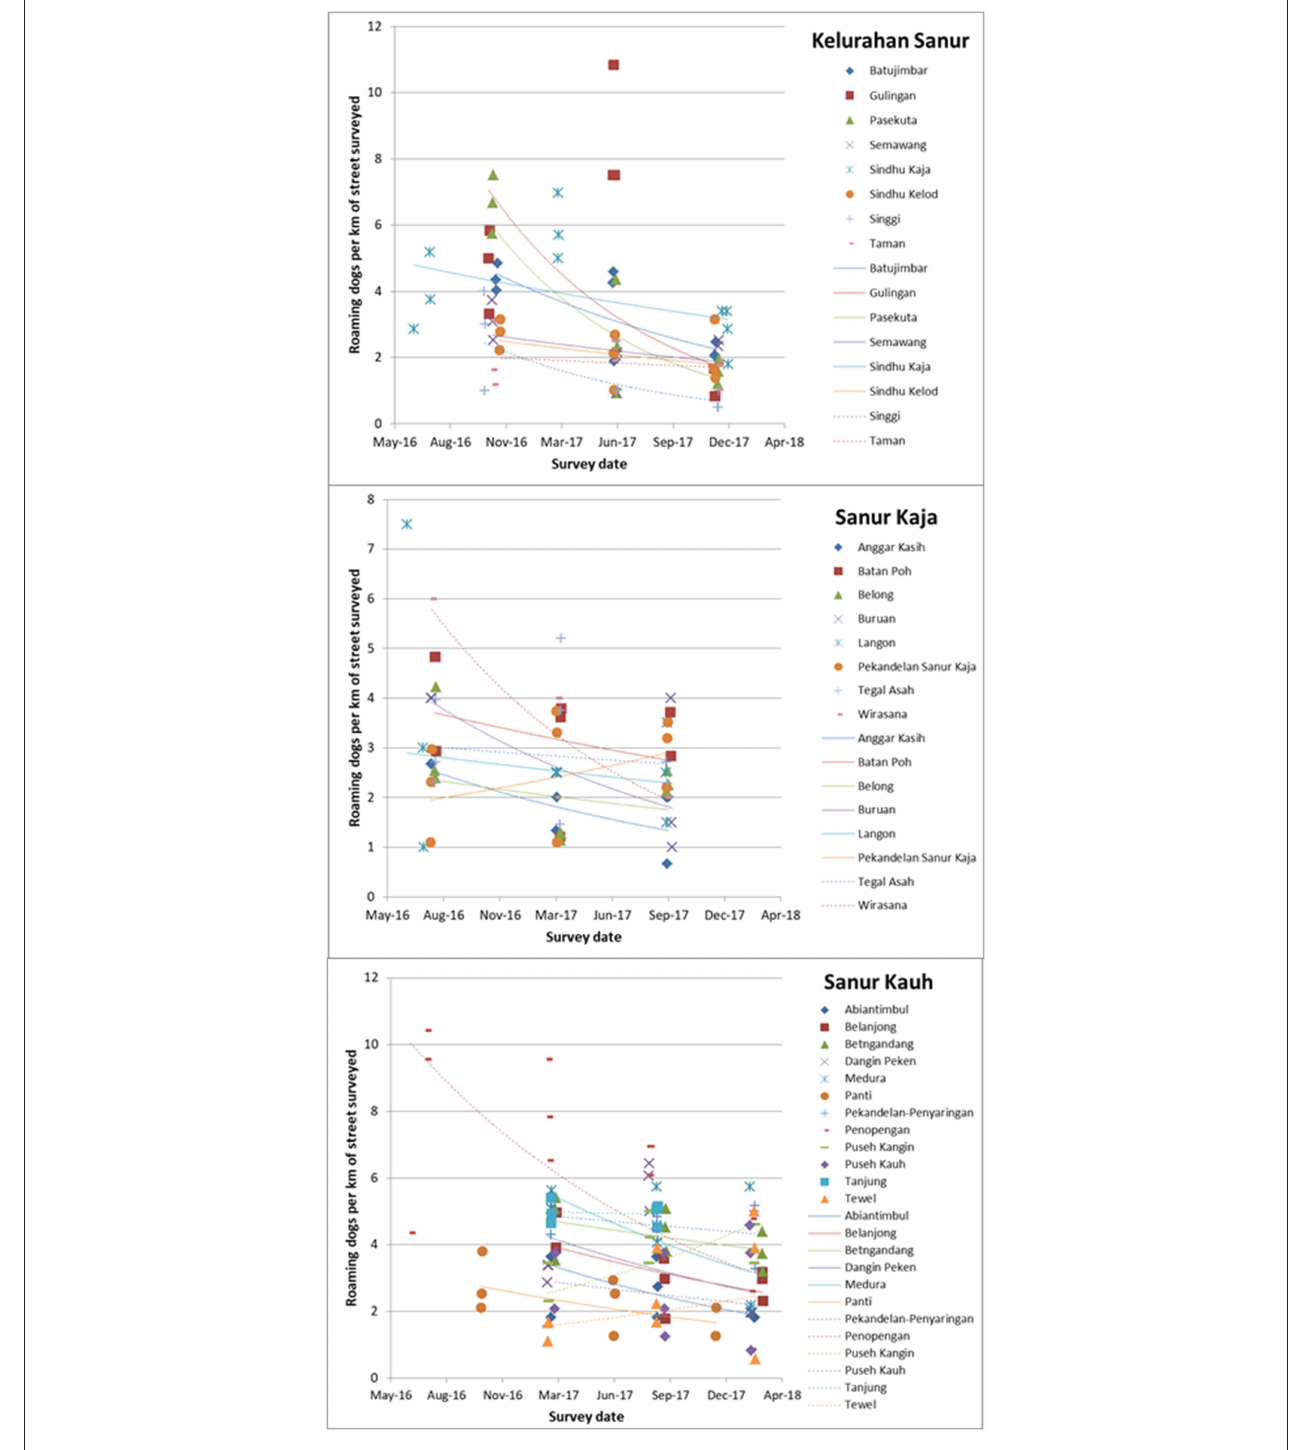
FIGURE 7 | (A–C) Change over time in the number of roaming dogs observed per km of street surveyed for each banjar within the three desas (Kelurahan Sanur, Sanur Kaja, Sanur Kauh). Colored icons represent roaming dog density on each of three replicate surveys along the same banjar survey route, across three street survey events every 6–8 months, with best fit exponential trendlines indicating the trend over time for each banjar .